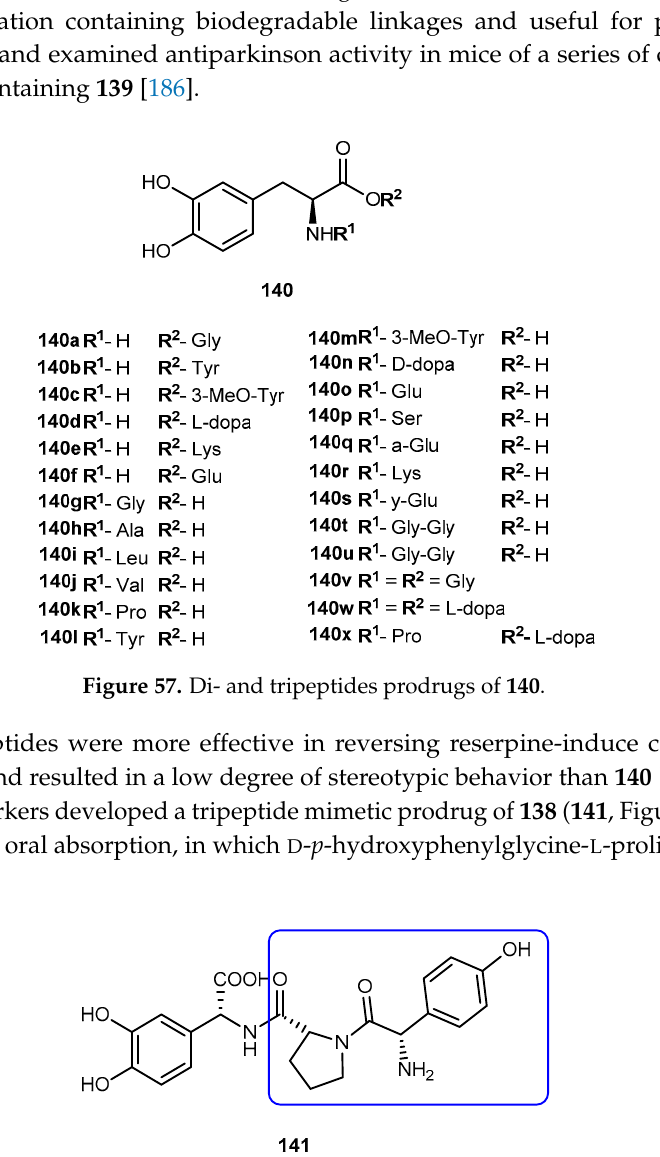
Figure 56. Chemical structure of dopamine ( 138 ) and its prodrug levodopa ( 139 ).